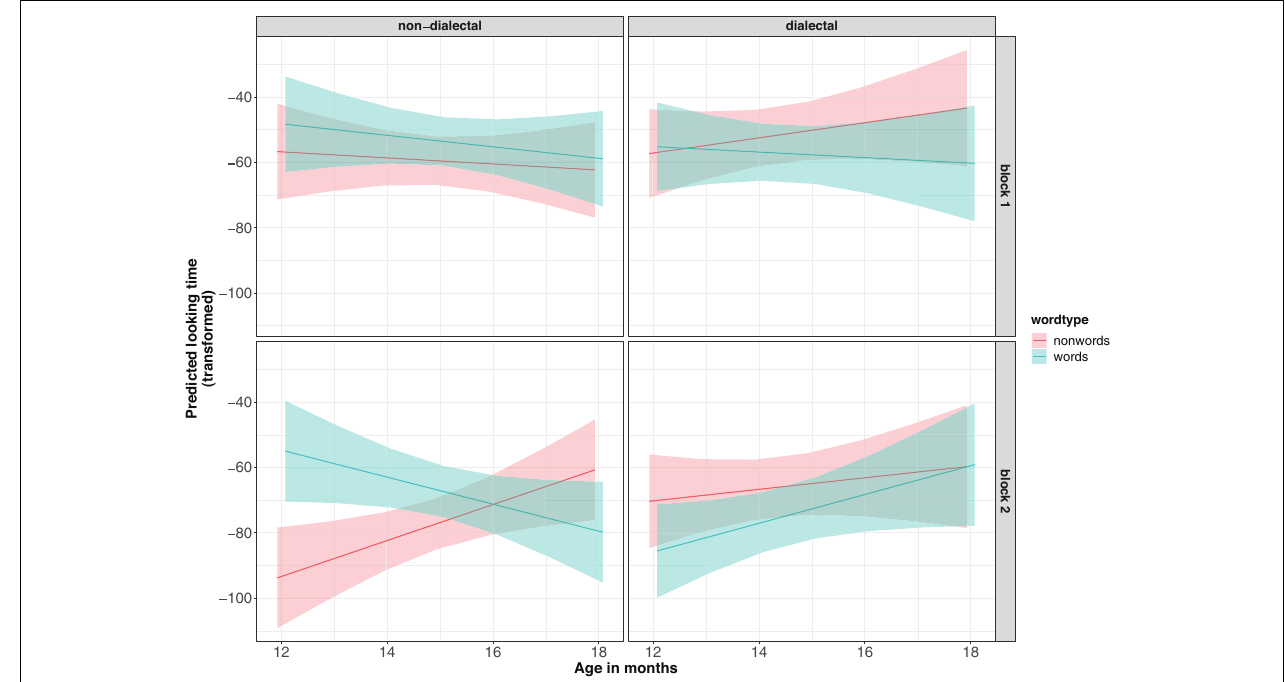
FIGURE 4 | Predicted effects of the model in Experiment 1. The y -axis shows the transformed looking times – sqrt(16,500-lookingtime). Higher values indicate longer looking times.